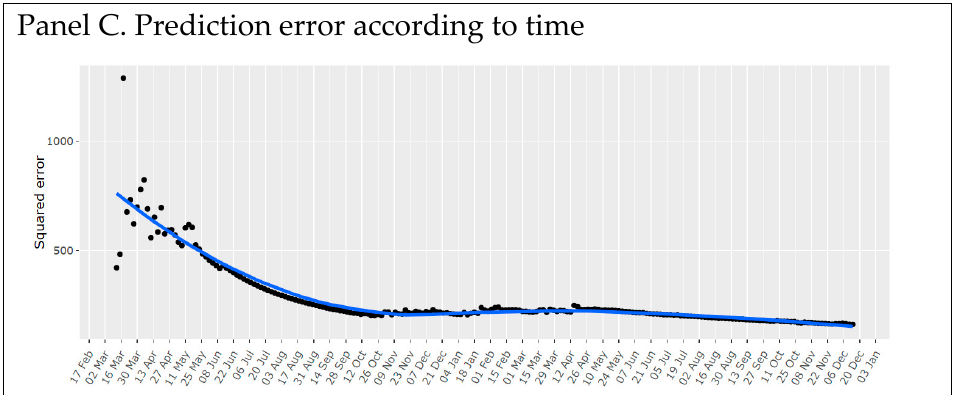
Figure 7. ICU forecasting tool of the COVID-19 advent app (web page screenshot). Panel ( A ): Retrospective forecasting estimates obtained by moving the slider toward the 11th of November. In red is the estimated ICU occupancy, and in blue are the observed ICU admissions. The red-shaded area indicates the 95% forecasting confidence intervals. Panel ( B ): Actual forecasting estimates obtained by moving the slider toward 11 November. In red is the estimated ICU occupancy, and in blue are the observed ICU admissions. The red-shaded area indicates the 95% forecasting confidence intervals. Panel ( C ): Forecasting error (squared error score) according to the forecasting time window (black dots); the blue line represents the local regression smoothing estimate